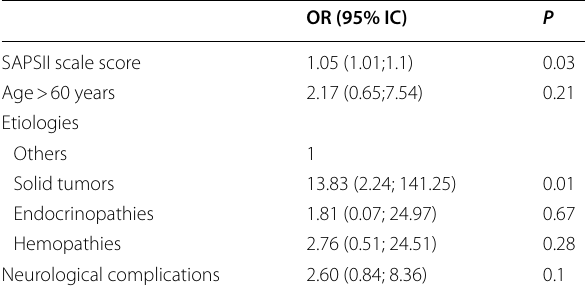
Table 6 Multivariate analysis of determinants of hospital